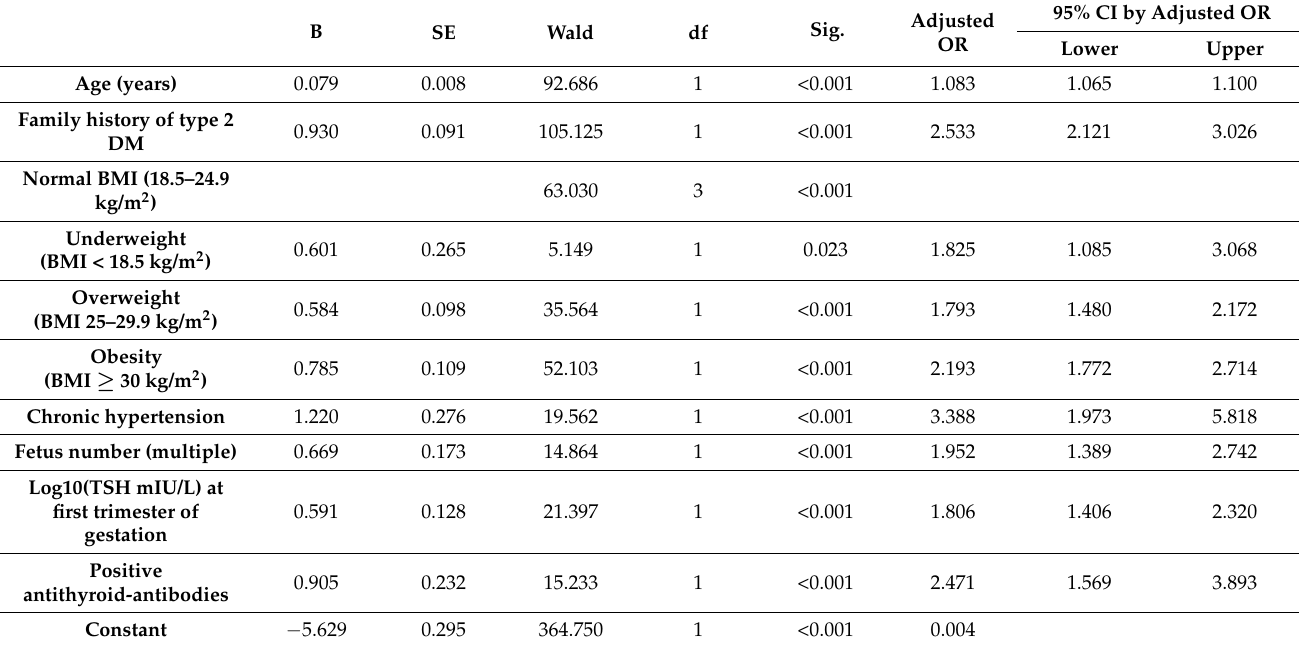
Table 3. Multivariate logistic regression analysis including first trimester TSH as a continuous quantitative variable (Model